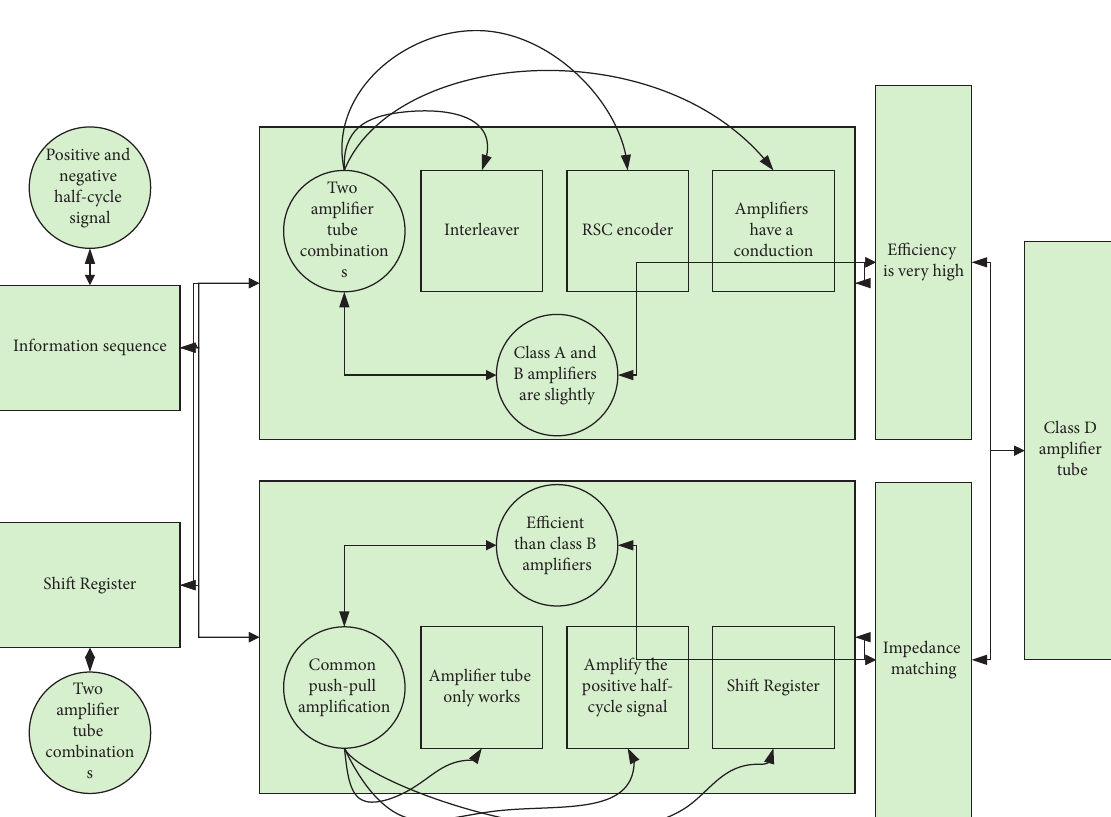
Figure 4: Parallel cascaded convolutional code encoder.